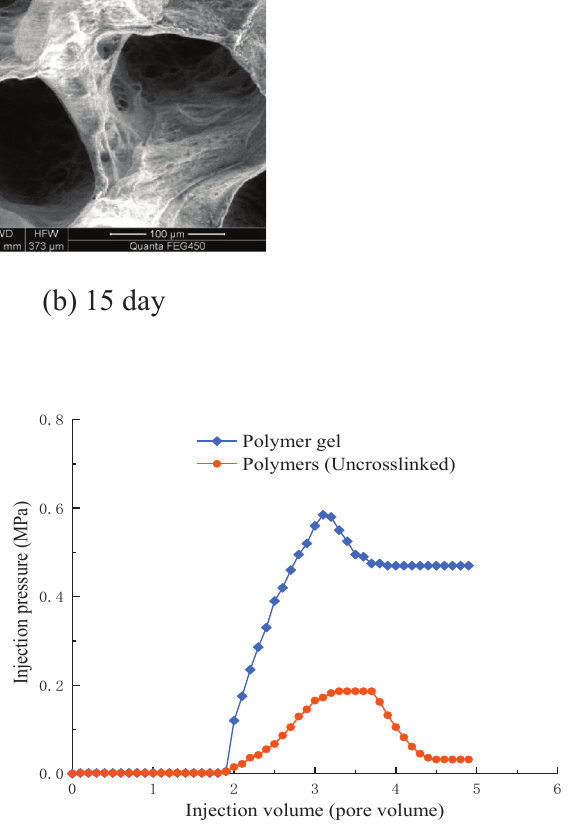
Figure 3: Injection pressure of polymer